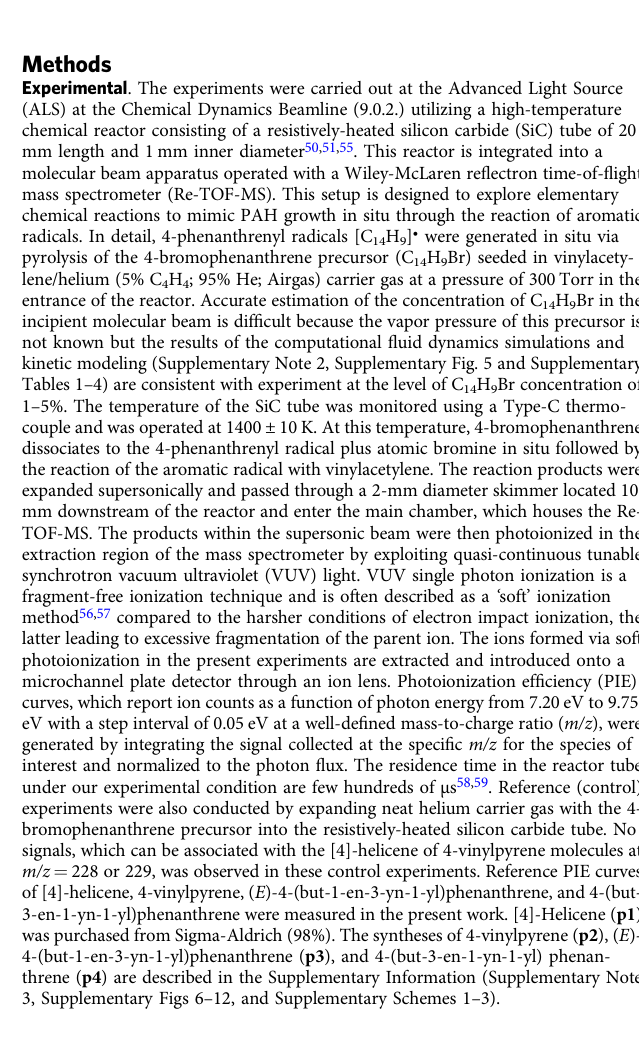
Fig. 5 Mechanism. Schematic presentation of a vinylacetylene mediated helicene propagation to [5]-helicene and [6]-helicene starting from [4]-helicene